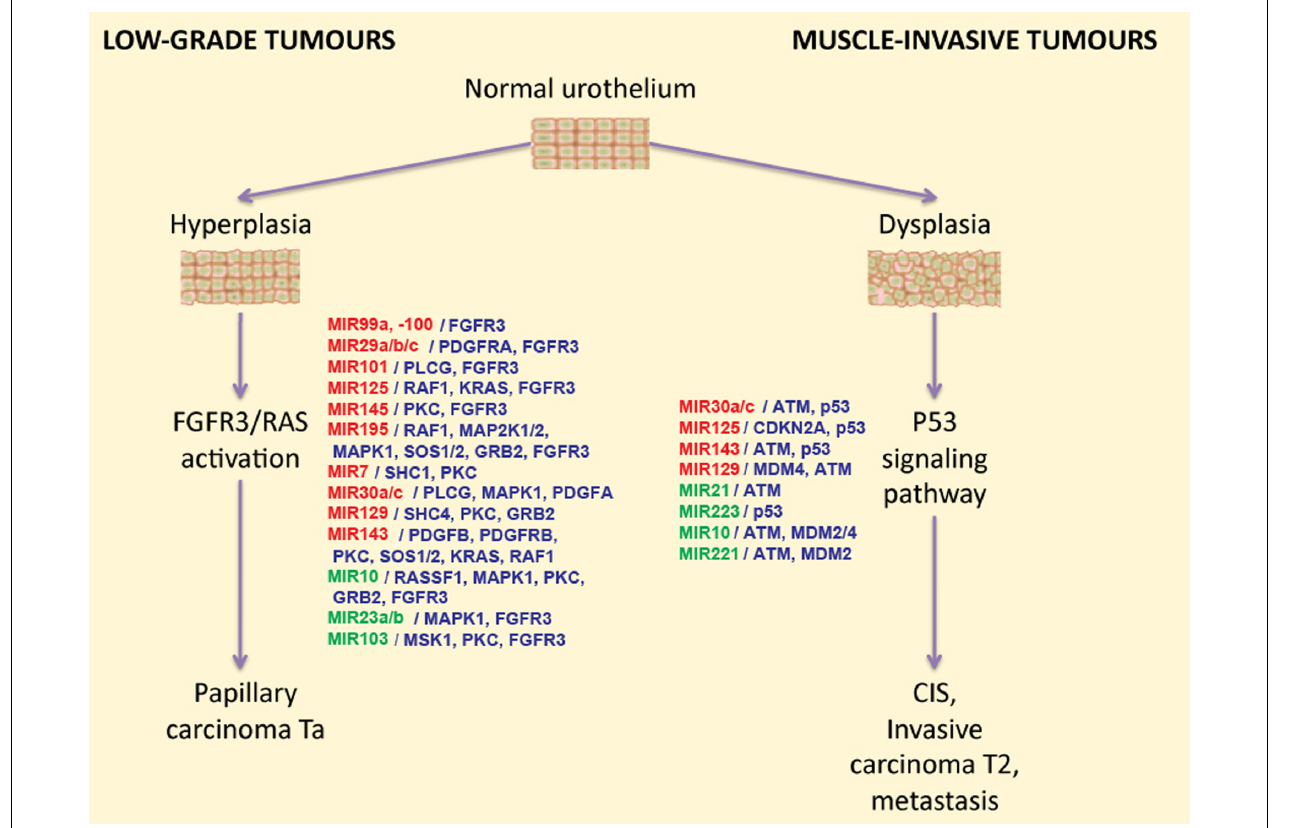
FIGURE 1 |The two-pathway model of different types of bladder cancer development, and the miRNAs that regulate these pathways. miRNAs that were reported to be down-regulated in BC are highlighted in red, and up-regulated miRNAs are highlighted in green. miRNA target genes are shown in blue in front of the respective miRNA